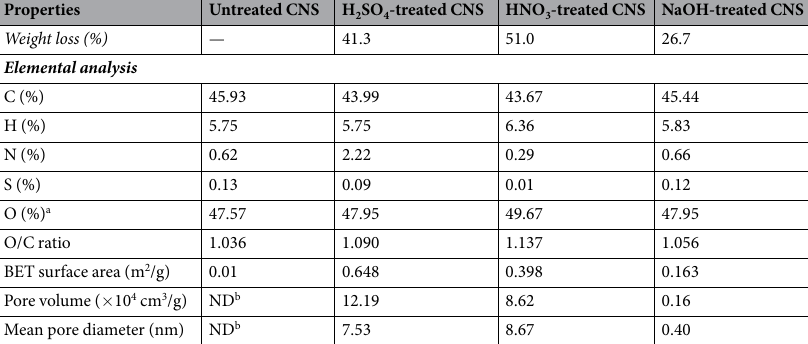
Table 1. Properties of untreated CNS and chemical treated CNS. a By difference b Not detectable.